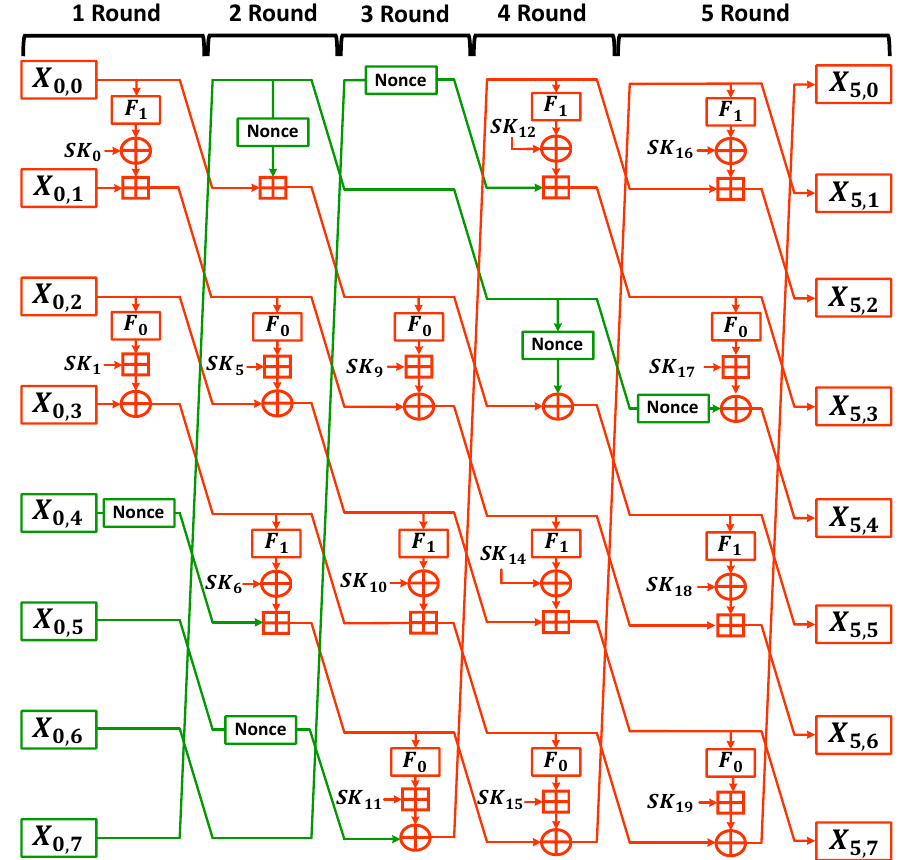
Figure 6. Optimization of HIGHT-CTR mode through partial pre-computation for the initial five rounds in previous work